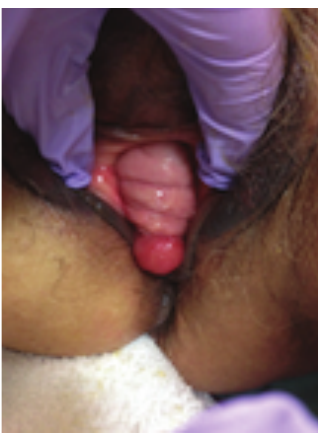
Figure 2: Examination demonstrating cystocele, normal vaginal tissue, and posterior rectovestibular fistula.